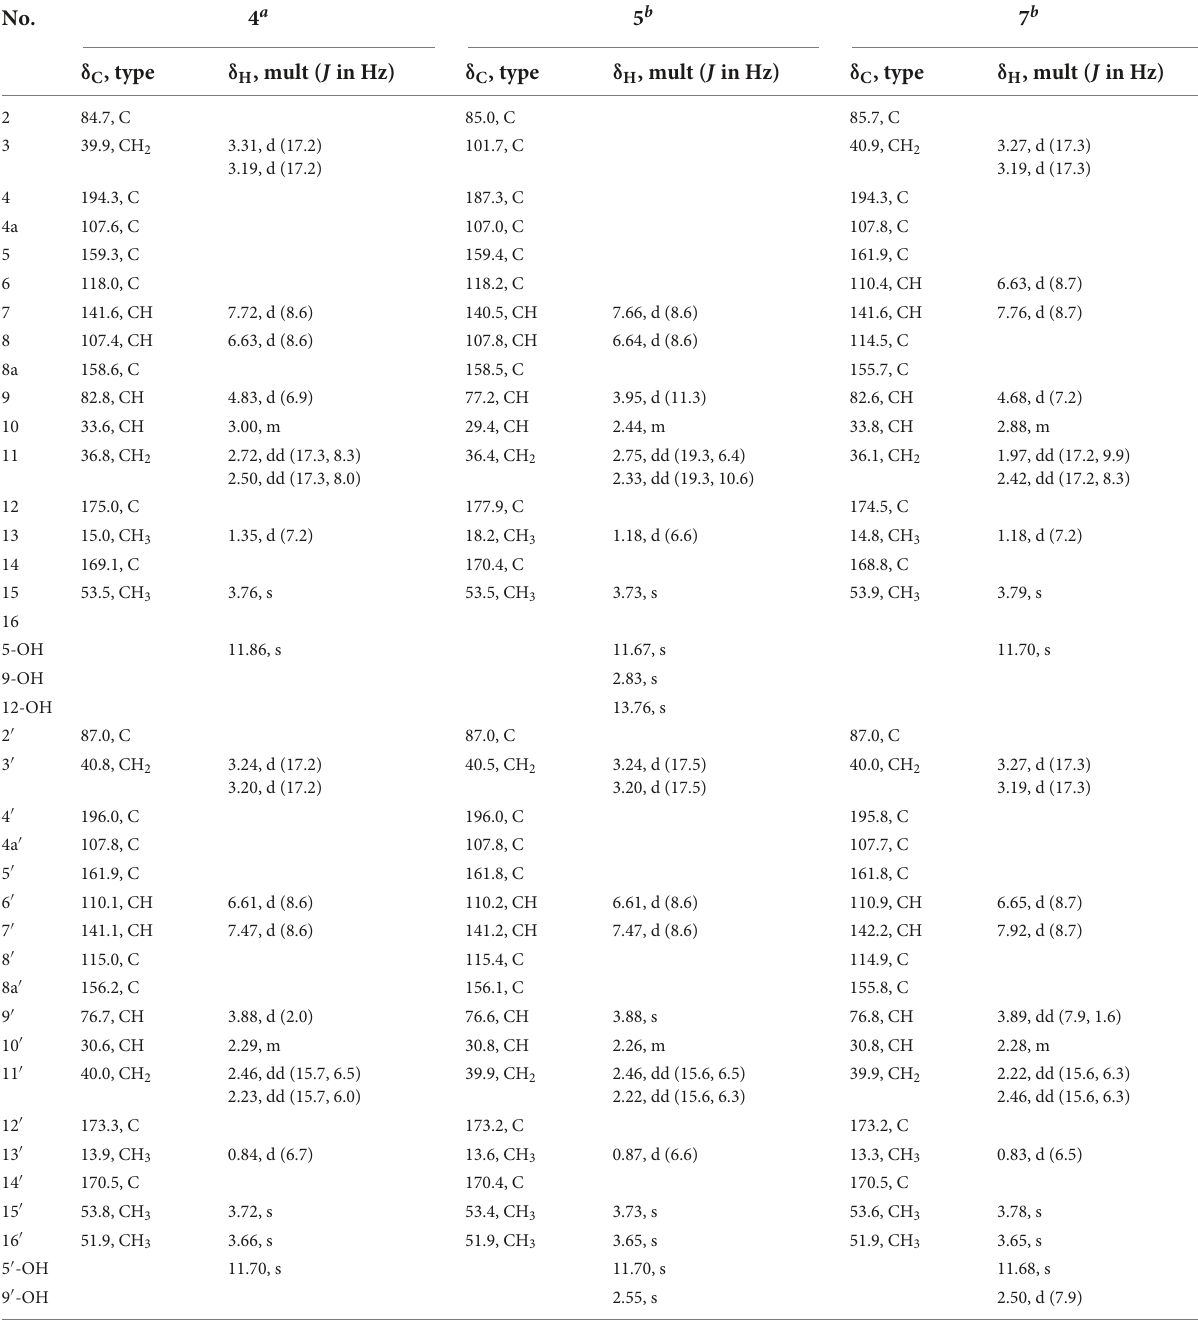
TABLE 2 1 H and 13 C NMR spectroscopic data of Compounds 4 , 5, and 7 (CDCl 3 ).